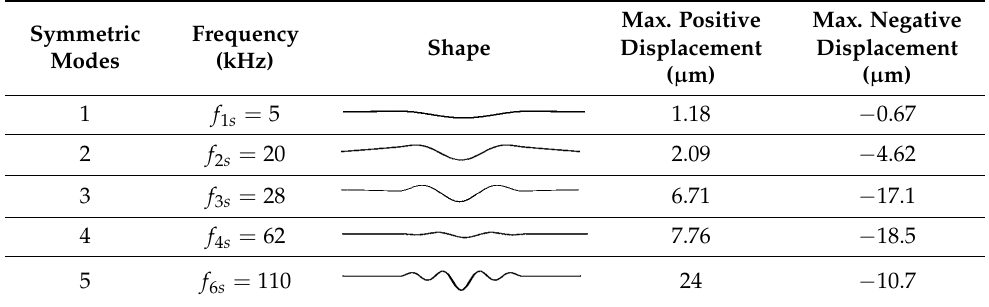
plate with conical shape apertures. The results gave the first five vibration modes. The subscript “s” indicates that the mode was identified as axisymmetric. In all cases, the largest out-of-plane displacements were identified in the center of the meshed thin plate, with a maximum 110-kHz mode found, the value close to those reported for an ultrasonic atomizer, with similar materials reported in Reference [11]. Table 3. A summary of the first five vibration modes, shapes, and amplitudes calculated with FEA.